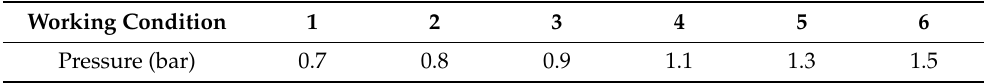
Table 2. Working conditions under different pressure